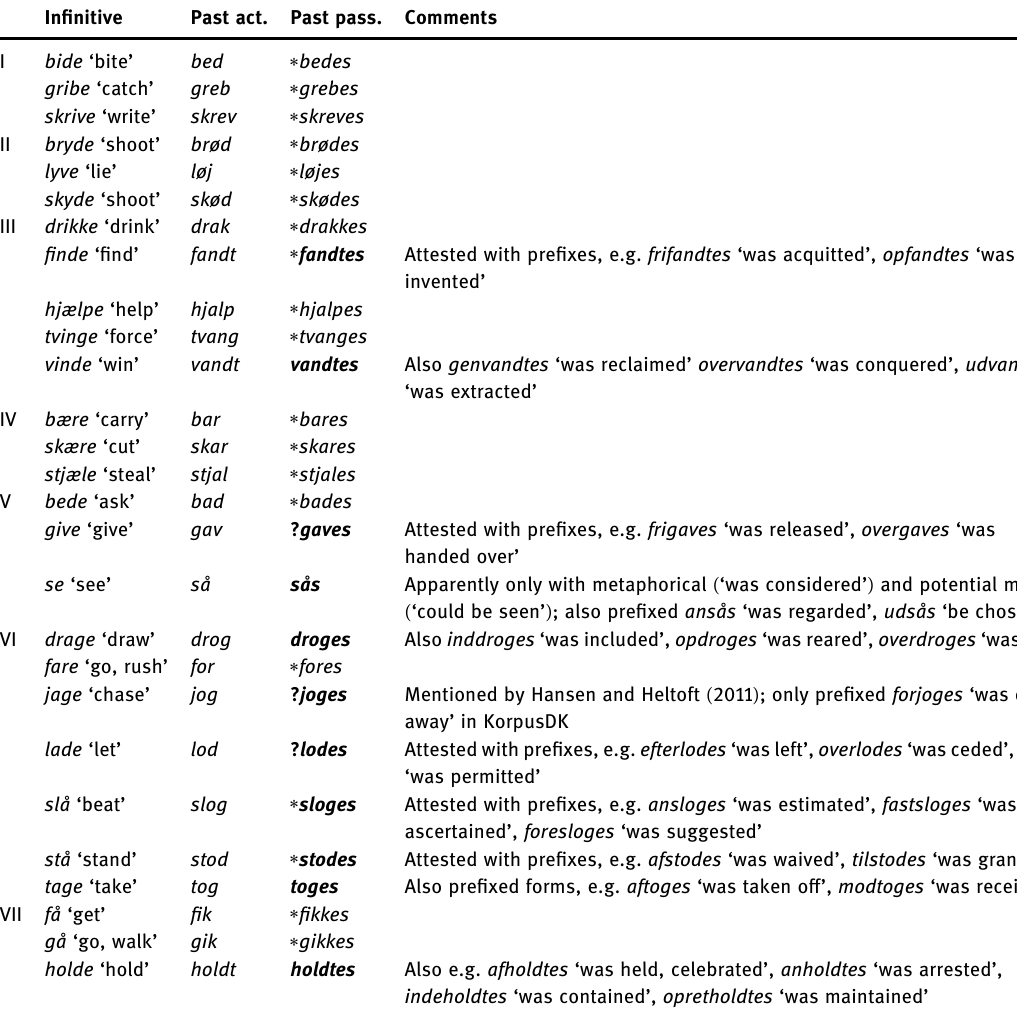
Table 3: Past - tense forms of strong conjugation classes In fi nitive Past act. Past pass.